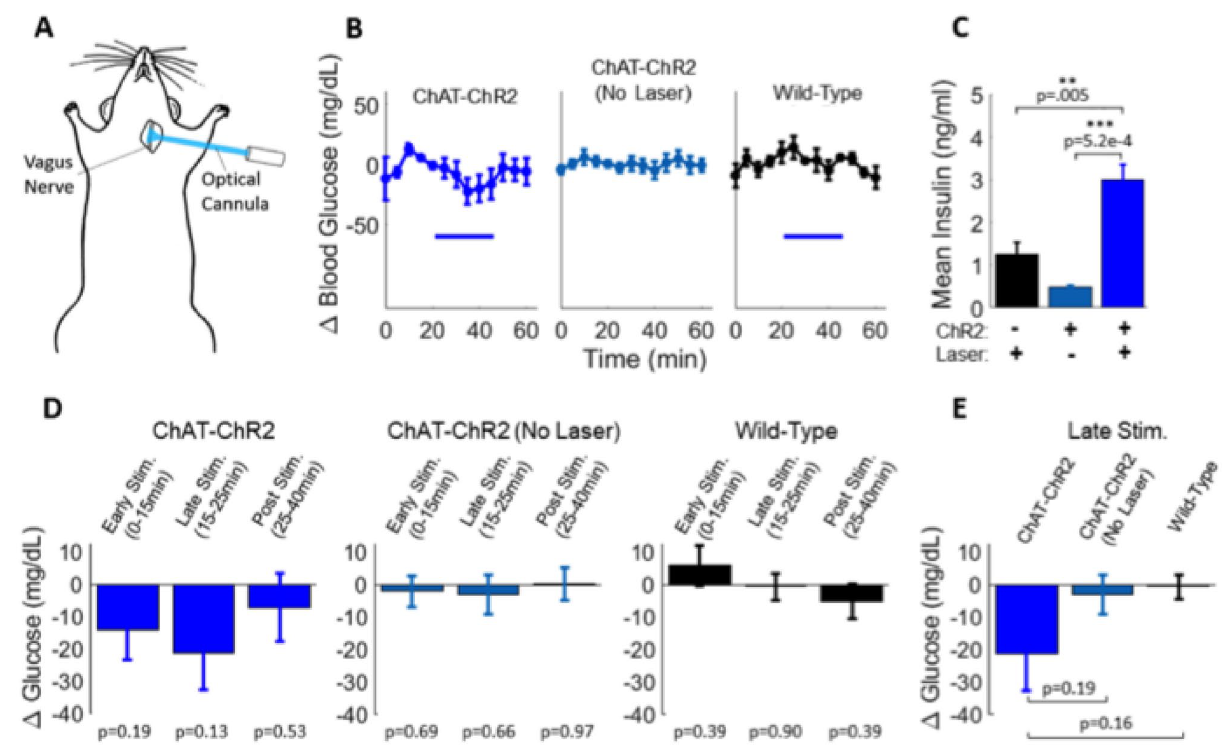
Figure 3. Cervical vagus nerve stimulation in the basal glucose state. ( A ) Schematic diagram of the location of laser stimulation. ( B ) Blood glucose levels in laser-stimulated ChAT-ChR2 mice (left, n = 6), non-laser- stimulated ChAT-ChR2 mice (middle, n = 6) and laser-stimulated wild-type mice (right, n = 5) (laser stimulation indicated by blue bar, 5 ms pulses, 20 Hz). ( C ) Quantification of post stimulation insulin levels showed a large, significant increase in the laser-stimulated ChAT-ChR2 group relative to controls. ( D ) Quantification of glucose changes in the early stimulation period (0-15 min following stimulation onset), late stimulation period (15–25 min) and post stimulation period (25–40 min). P-values refer to comparison with respect to pre- stimulus level. ( E ) Comparison of glucose changes during the late stimulation period across the three groups. Data in ( B – E ) presented as the mean over n = 6 ChaT-ChR2 recordings (with light and without light) and n = 5 WT recordings. Error bars represent standard error in the